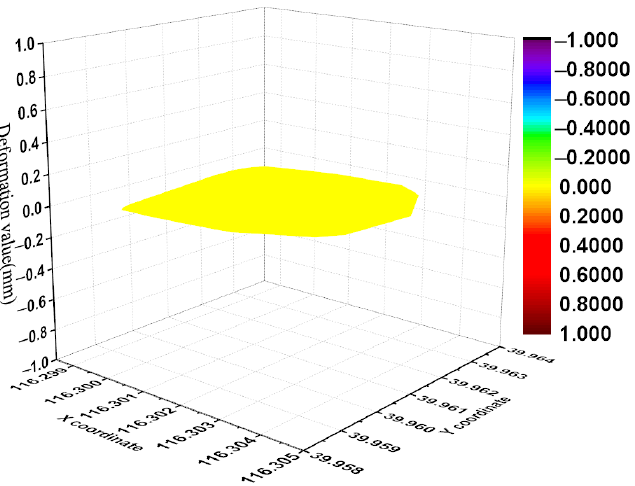
Figure 10. Plane model of the first-issue data (30 September 2011).